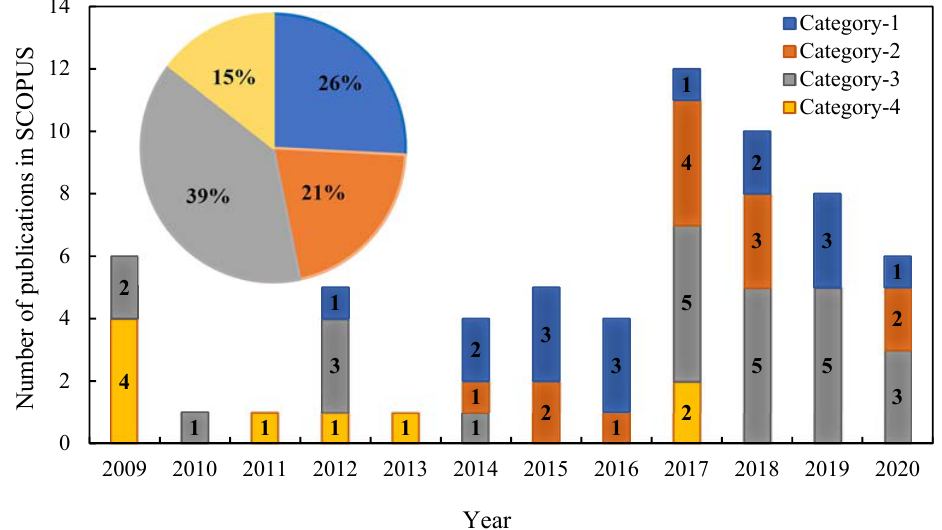
Figure 4. Distribution of the reviewed articles associated with the application of LCSs for indoor monitoring of buildings from 2009 to 2020. Category-1: Energy efficiency of the electrical appliance, category-2: controlling of the air quality and the pollutions, category-3: thermal comfort and HVAC, and category-4: other aspects of indoor monitoring of buildings .